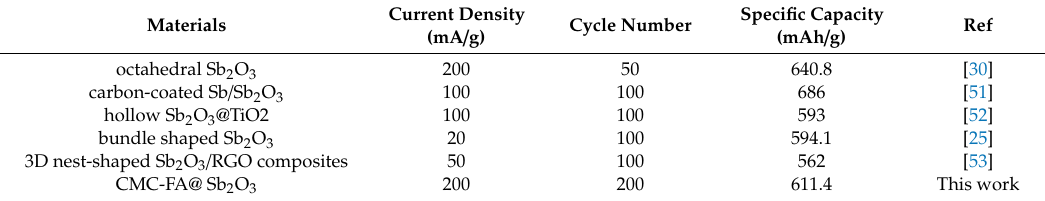
Table 1. Comparison of the electrochemical performances of CMC-FA@Sb 2 O 3 with previously reported Sb 2 O 3 -based composites as anode materials for lithium ion batteries.